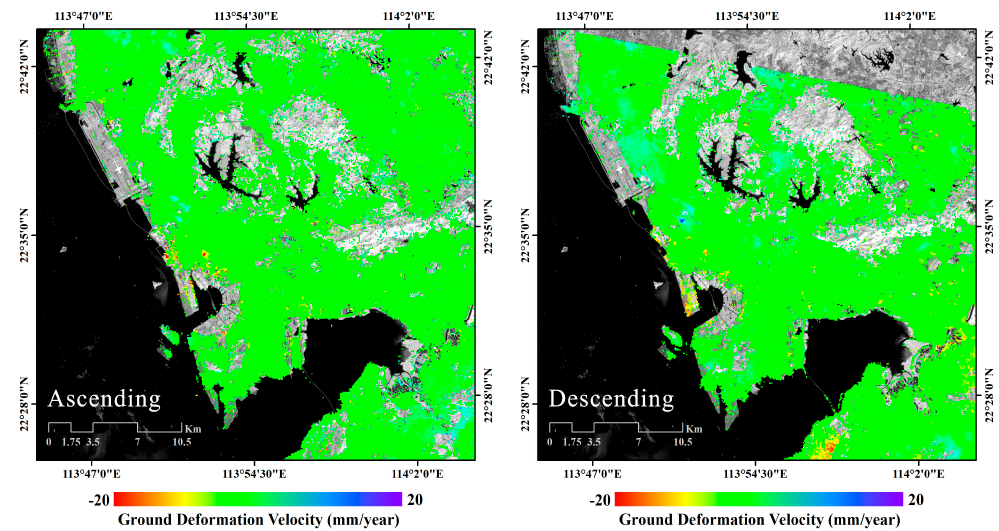
Figure 11. Shenzhen area results. Maps of ascending ( left ) and descending ( right ) mean deformation velocities retrieved by the ascending and descending ENV datasets. Only well-processed coherent SAR pixels exhibiting a temporal coherence larger than 0.6 were considered.